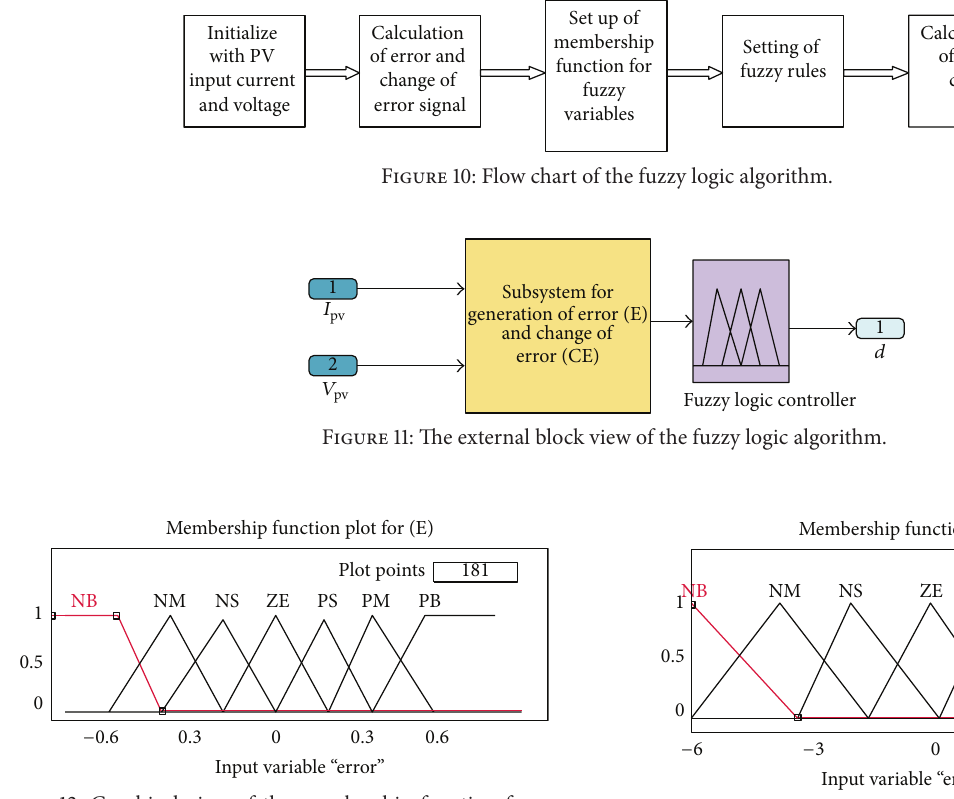
Figure 12: Graphical view of the membership function for error signal.